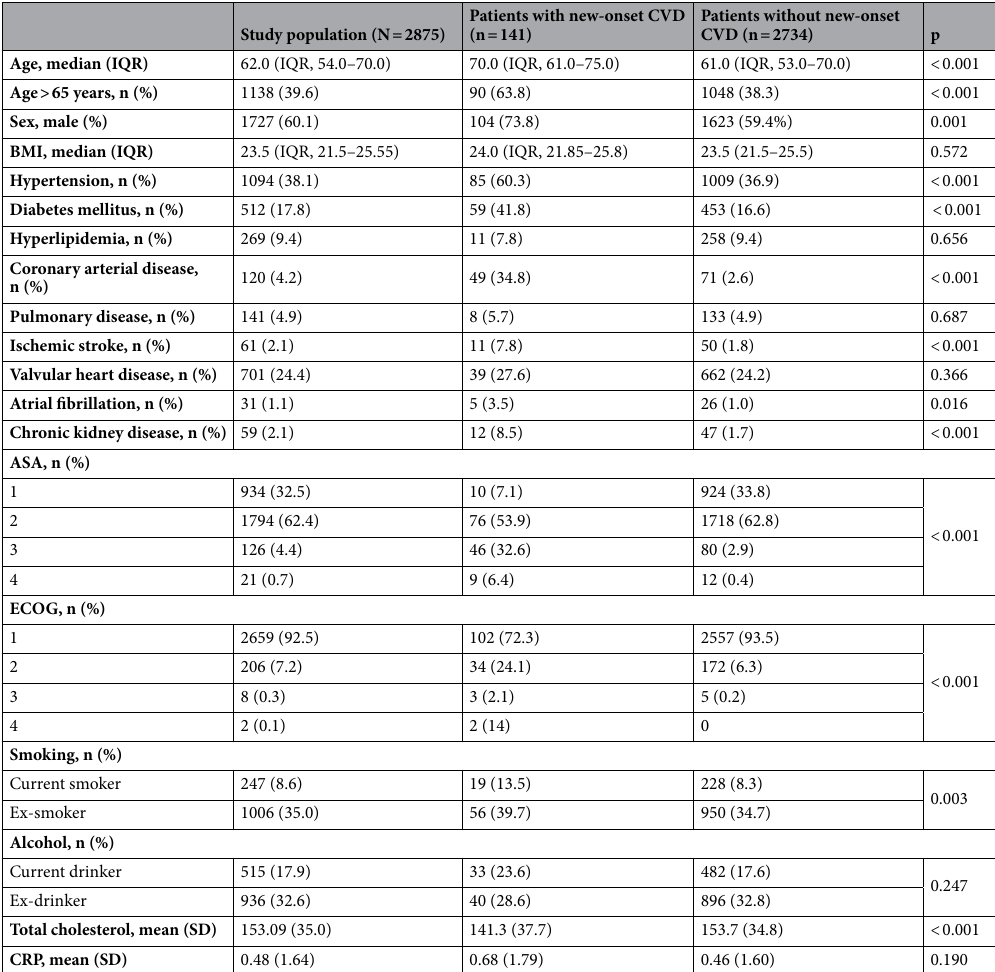
Table 1. Baseline clinical characteristics of the patients. CVD cardiovascular disease, IQR interquartile range, BMI body mass index, ASA American Society of Anesthesiologists Physical Status Classification System, ECOG Eastern Cooperative Oncology Group performance status, SD standard deviation, CRP c-reactive